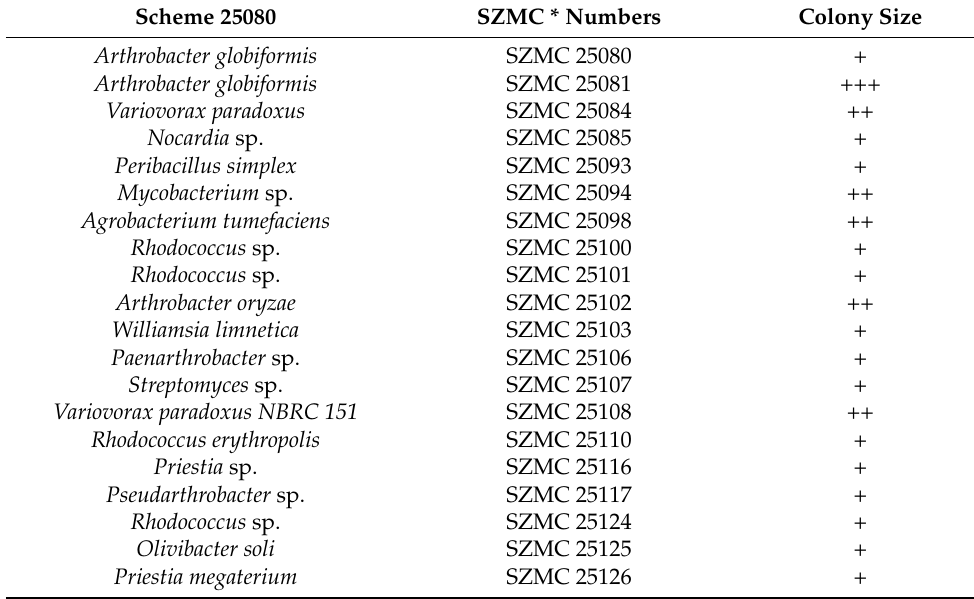
Table 3. Growth of different bacterial isolates on nitrogen free medium.